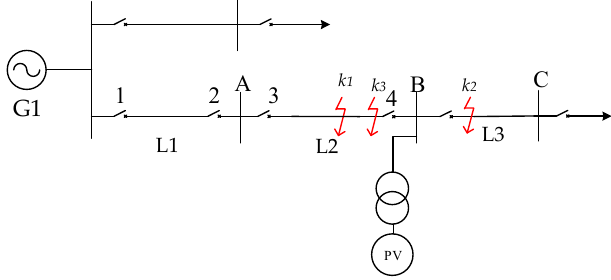
Figure 5. A diagram of the distribution network with IIG integration.